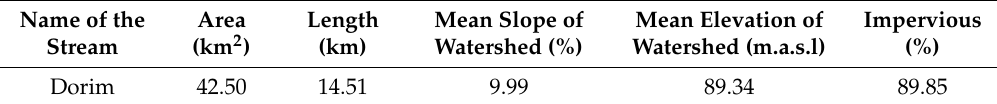
Figure 3. Watershed of Dorim Stream. Table 2. Watershed properties of Dorim Stream.